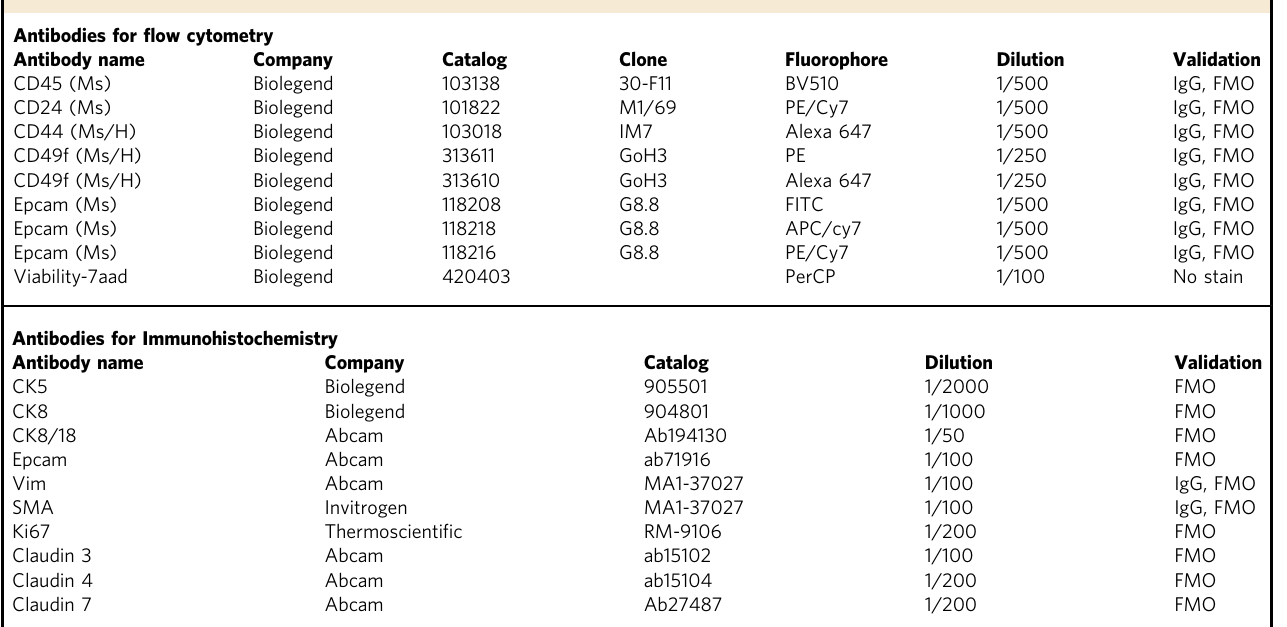
Table 3 Antibodies used for fl ow cytometry and immunohistochemistry analysis. Antibodies for fl ow cytometry Antibody